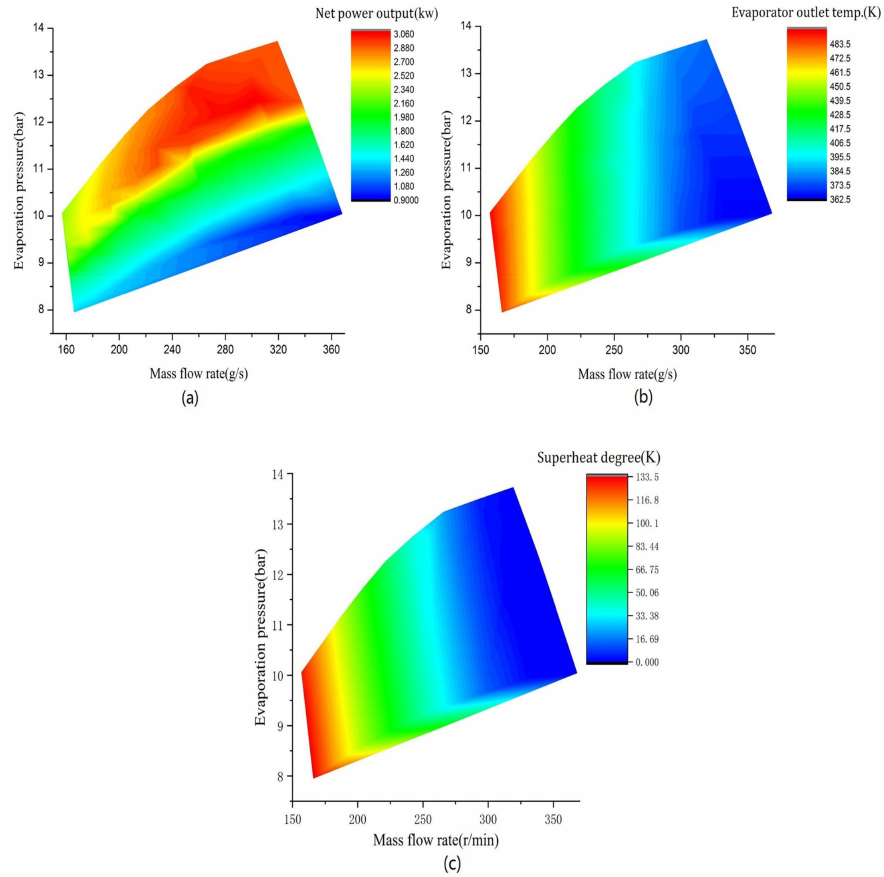
Figure 6. Influences of the mass flow rate and the evaporation pressure on the ORC system performance: ( a ) The net power output, ( b ) the temperature at the outlet of the evaporator, and ( c ) the superheat degree. When the engine operated under the rated power point, the evaluated optimal mass flow rate was approximately 300 g / s. In Figure 6a, a high value for the net power output was obtained with a mass flow rate in the range of 280–320 g / s. If the mass flow rate was too small, the evaporation pressure would decrease. If the mass flow rate was too large, the superheat degree would drop, which had a negative influence on the net